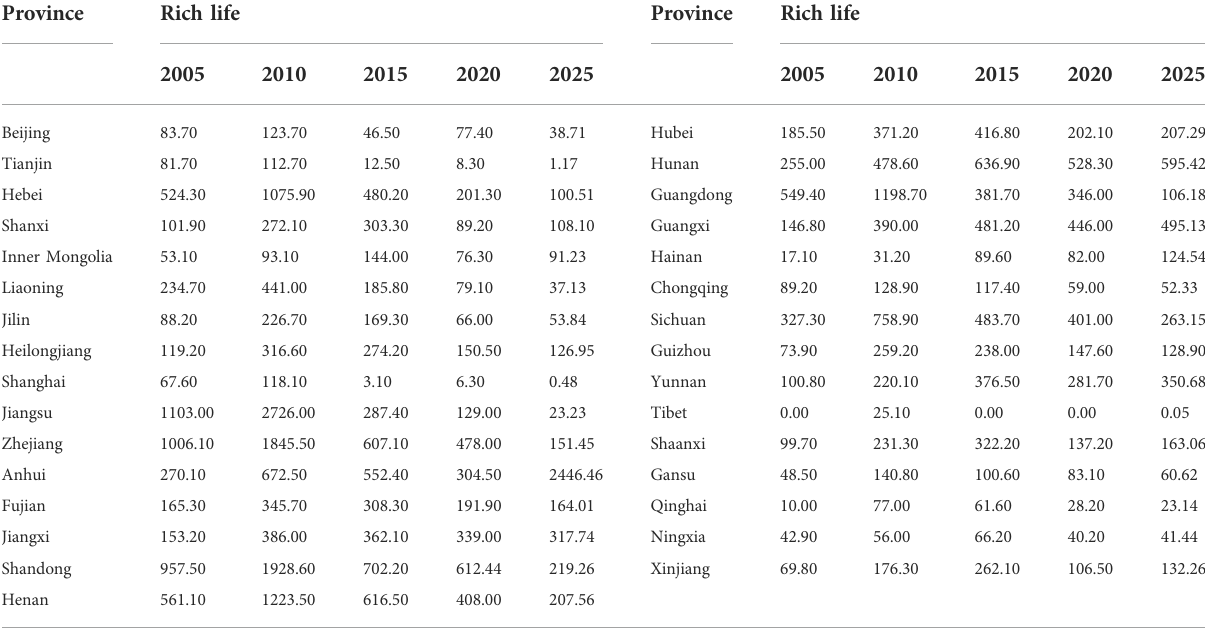
TABLE 6 Financial expenditure of af fl uent living in 31PLAD (unit: 100